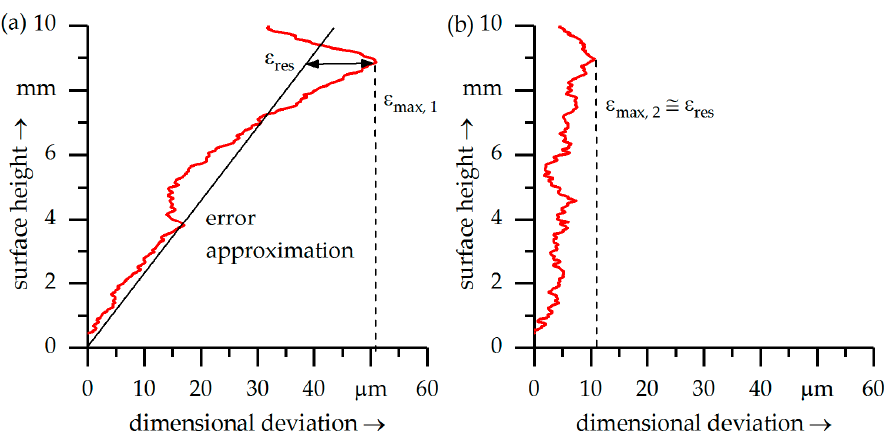
Figure 5. Error reduction via tool path adjustment ( v c = 140 m 0.2 mm; b w = 1.0 mm; end mill 4): ( a ) initial surface error; ( b ) surface error after tool path adjustment.